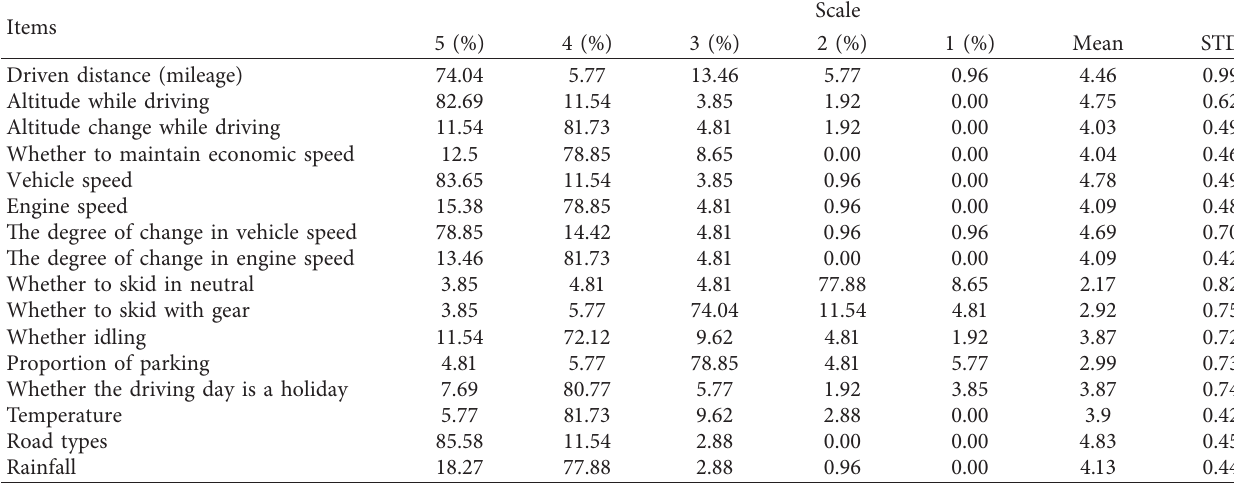
Table 1: The second part of the